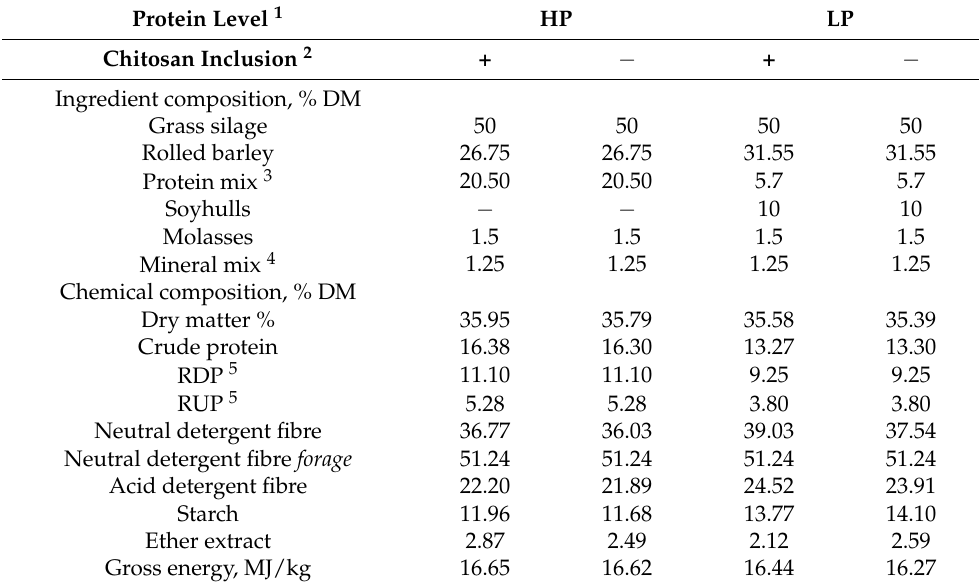
Table 1. Ingredient composition and chemical composition of dietary